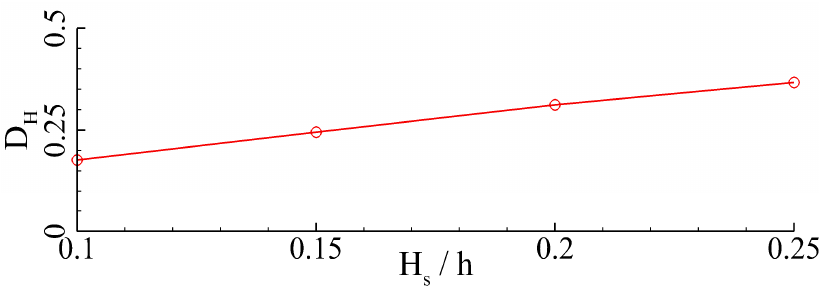
Figure 15. Dissipation rate of the wave energy under different significant wave heights.